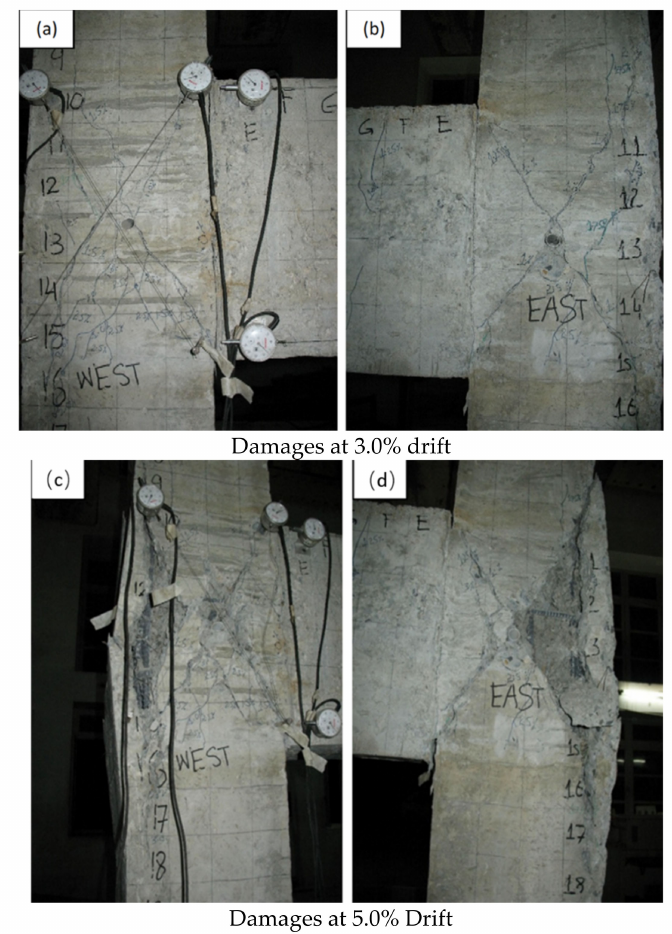
Figure 15. Damages observed in a beam–column joint with increasing drift demand. ( a ) represents the west-side face of damages at 3.0% drift ( b ) represents the east-side face of damages at 3.0% drift. ( c ) represents the west-side face of damages at 5.0% drift ( d ) represents the east-side face of damages at 5.0%